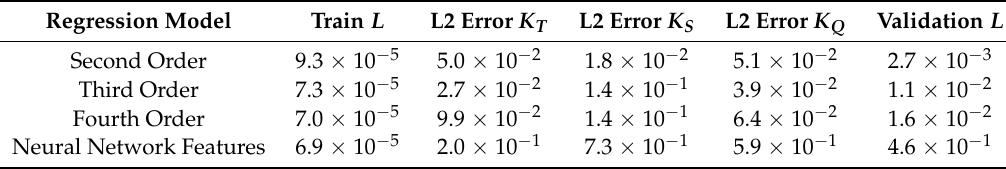
Table 4. L2 norm error for different tolerances of L for validation of neural network for behind condition forces.